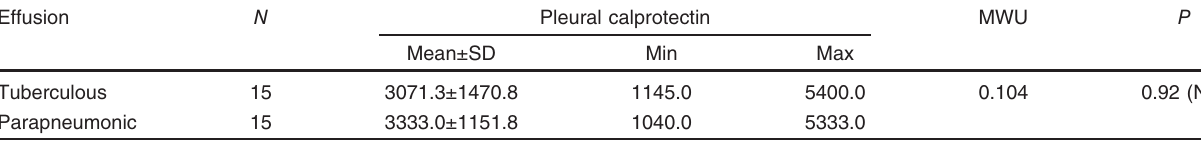
Tuberculous Parapneumonic